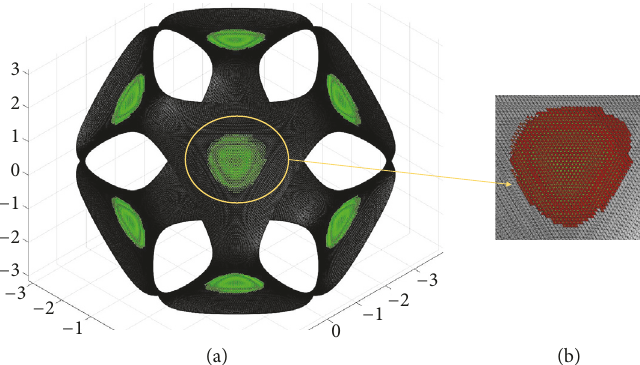
Figure 10: (a) Concave regions recognition for the P-surface with k = -0.7 and s = 1. (b) A magnified view of one of these regions.